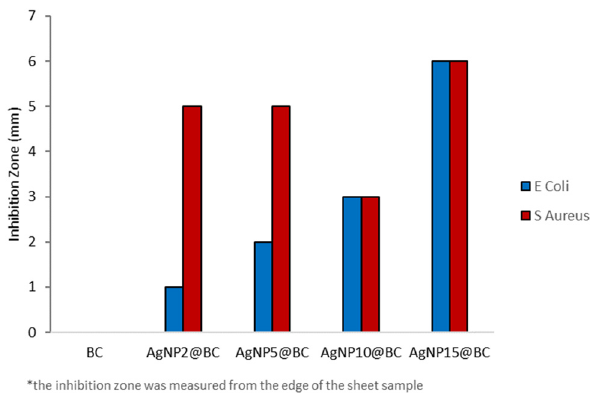
Figure 10: Inhibition zone of BC and AgNPs templated BC against S. aureus and E. coli .